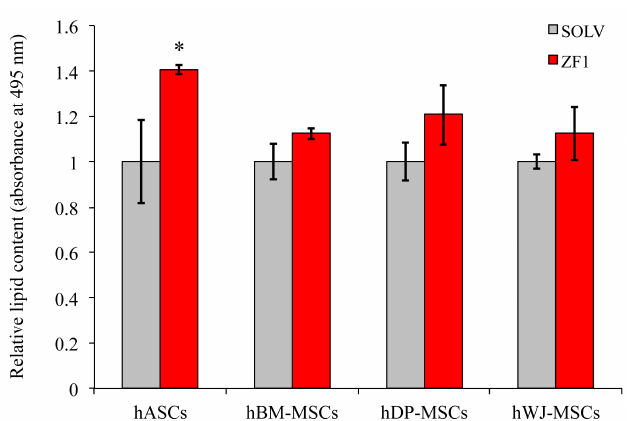
Figure 12. E ff ects of ZF1 treatment on adipogenic di ff erentiation in hMSCs. The hASCs, hBM-MSCs, hDP-MSCs, and hWJ-MSCs, at the 5th passage, were exposed for 72 h in the presence of 20 µ g / mL ZF1, or a solvent as a control (SOLV). An experiment was performed in technical triplicate for each cell type. At the end of treatment, hMSCs were incubated with adipogenic medium for two weeks and then di ff erentiation was assessed using Oil Red O staining. The lipid-rich vacuoles Oil Red O dye was extracted from each well and its absorbance was read at 495 nm with a spectrophotometer. Data are expressed as mean relative lipid content (absorbance at 495 nm) of the ZF1 treated cells over the solvent treated ones (used as control, SOLV = 1) ± SD and statistical significance was evaluated using the Student’s t -test, * p < 0.05, n = 3.